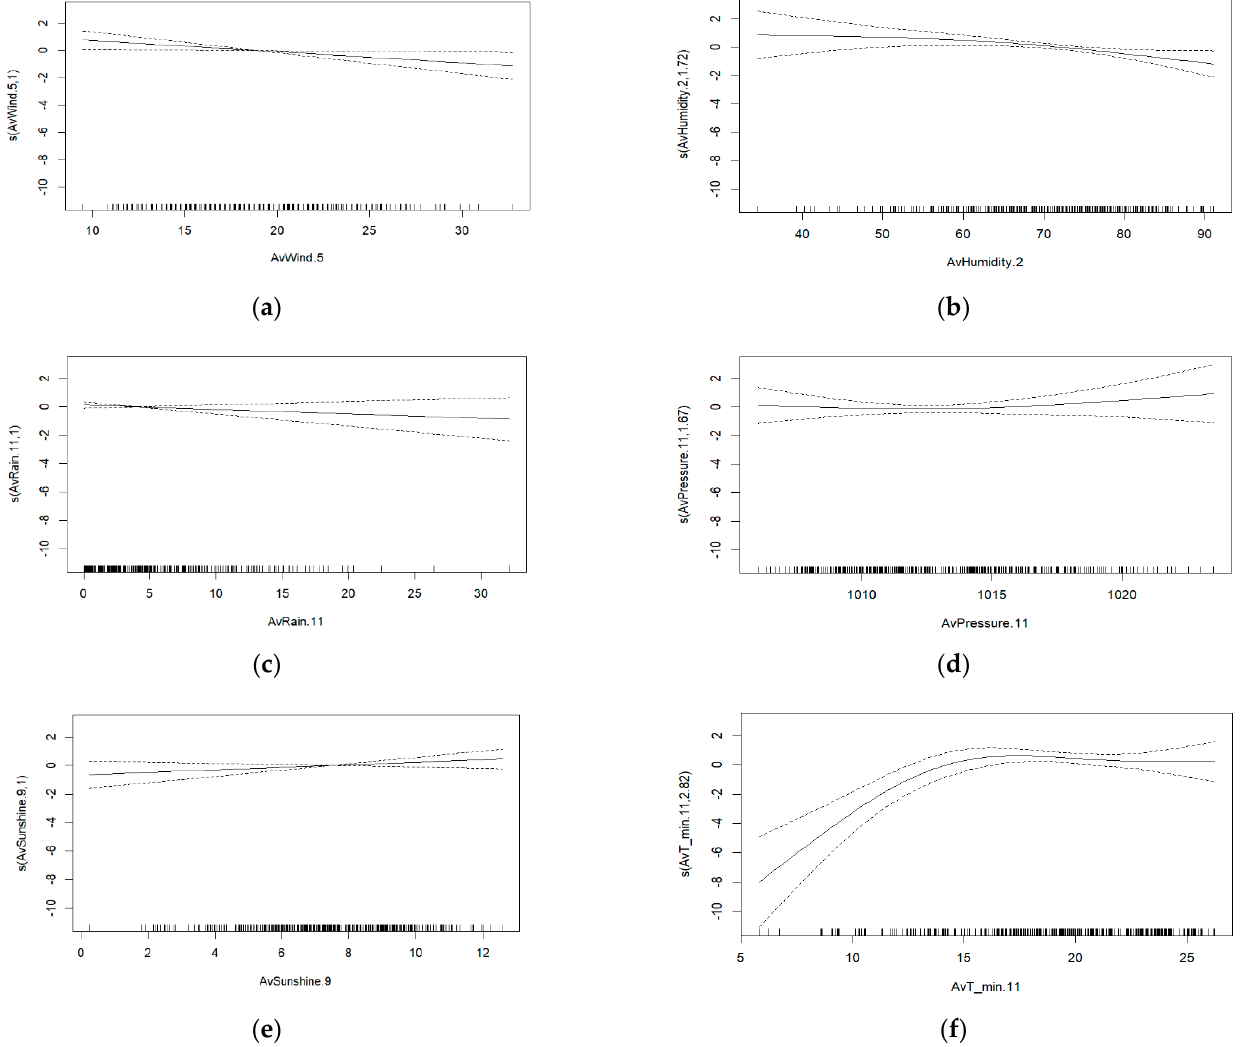
Figure 3. Association between dengue fever cases and ( a ) wind, ( b ) relative humidity, ( c ) atmo- spheric pressure, ( d ) precipitation, ( e ) sunshine, and ( f ) minimum temperature during 2014–2020, Asuncion,